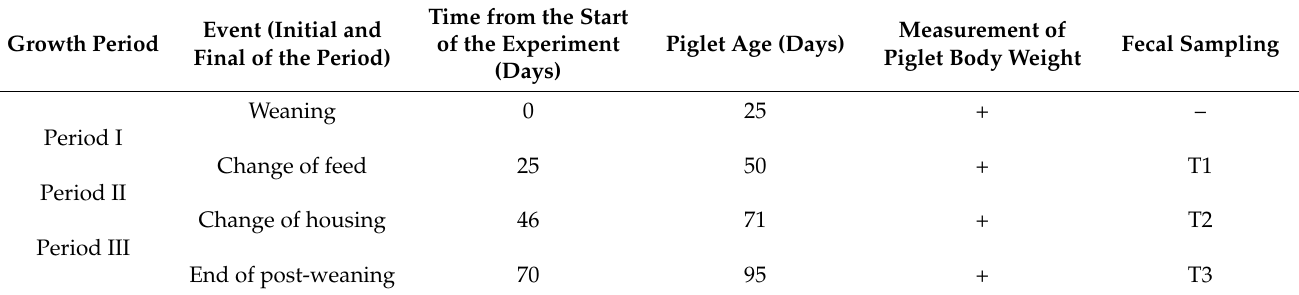
Table 1. Time sequence of events from weaning to the end of the experiment.